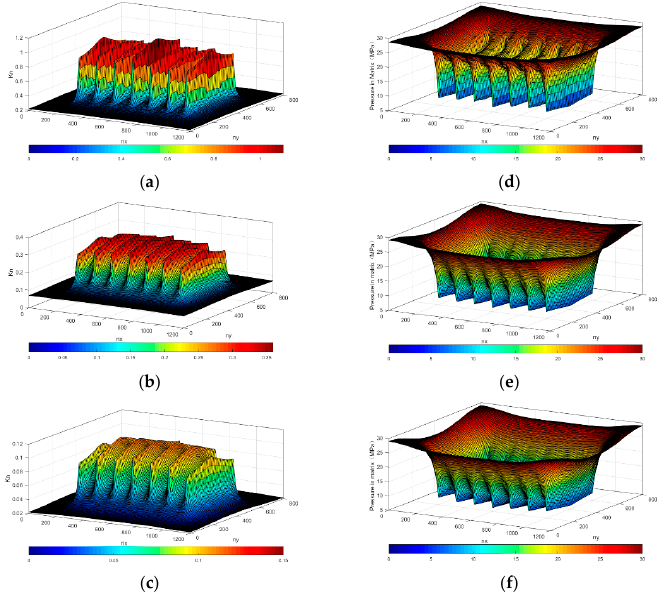
Figure 10. Field distribution of Knudsen number and matrix pressure in shale gas reservoir. ( a ) k m = 10 − 5 mD, Kn; ( b ) k m = 10 − 4 mD, Kn; ( c ) k m = 10 − 3 mD, Kn; ( d ) k m = 10 − 5 mD, p m ; ( e ) k m = 10 − 4 mD, p m ; ( f ) k m = 10 − 3 mD, p m